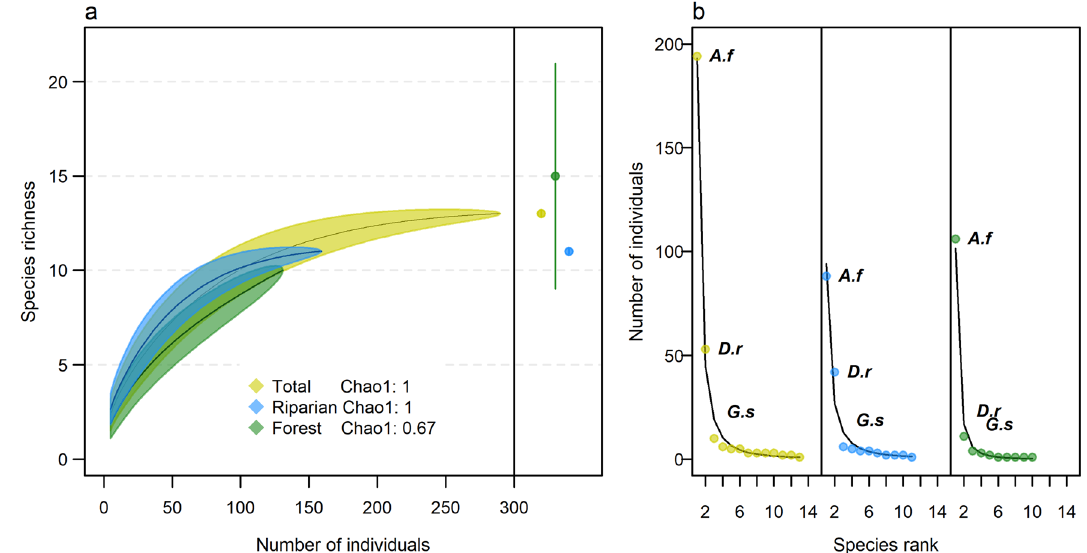
Figure 1. Understory bat community structure for the entire study area and forest and riparian habitats nested within sites showing: ( a ) species accumulation curves with 95% confidence intervals based on individual- based rarefaction, Chao1 richness estimates of the complete assemblage in each habitat with 95% confidence intervals (points on right), and the completeness index calculated from the Chao1 estimator; and ( b ) species’ rank abundances. Initials correspond to species names: Artibeus fraterculus (A.f.), Desmodus rotundus (D.r.), and Glossophaga soricina (G.s.). Colors in ( b ) correspond to the entire study area, riparian habitat, and forest habitat as in ( a ).